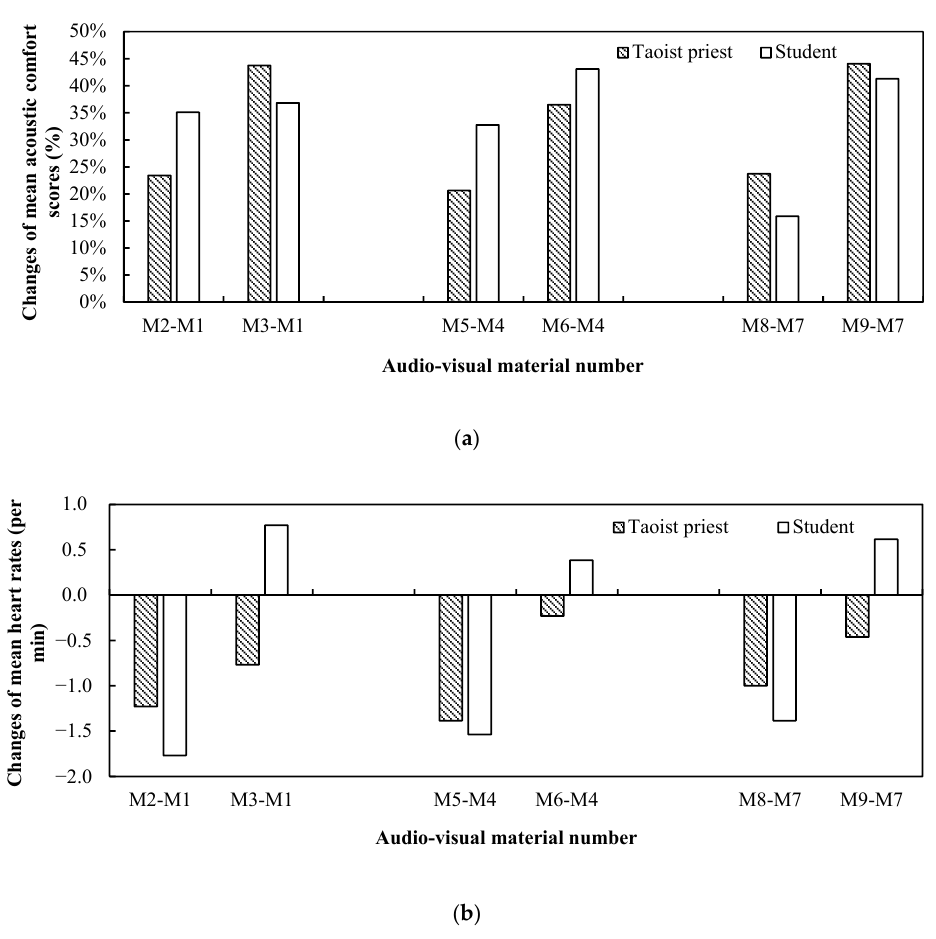
Figure 9. Audio-visual interaction results of Taoist priests and ordinary people after experiencing audio-visual materials: ( a ) changes of the mean acoustic comfort scores after adding bird sound and Taoist music to the control groups; ( b ) changes of the mean heart rates after adding bird sound and Taoist music to the control groups.